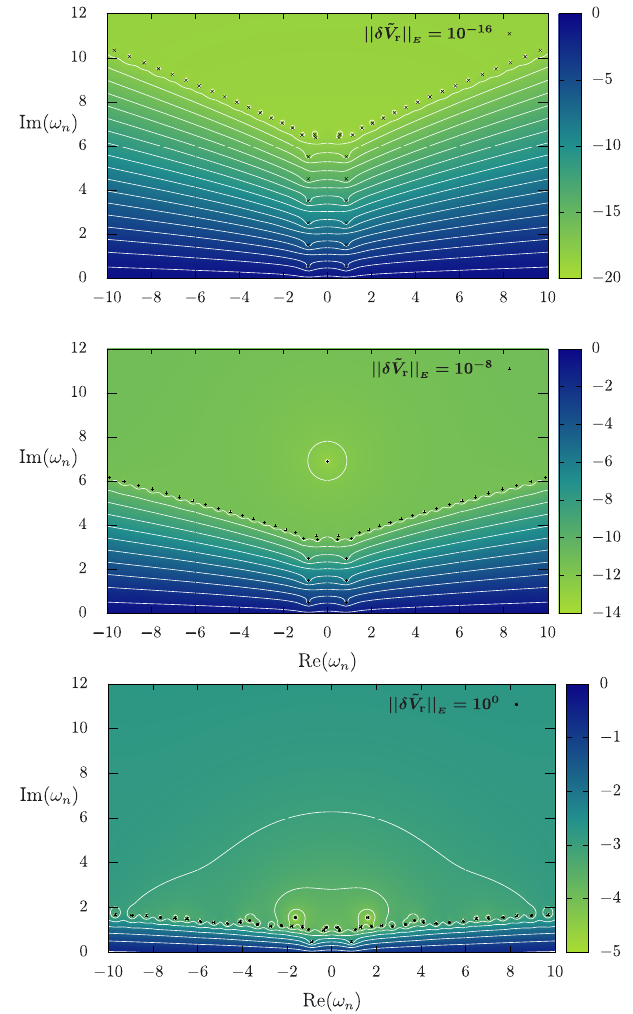
FIG. 11. Pseudospectra of the Pöschl-Teller potential under ˜ V random perturbations δ of increasing norm, demonstrating the r regularizing effect of random perturbations. Pseudospectra sets σ ϵ bounded by the contour line reached by perturbed QNMs become flat, a signature of improved analytic behavior of the resolvent, as illustrated in Fig. 6. Pseudospectra sets not attained by the ω Þ perturbation remain unchanged. Regularization of R L þ δ L ð ˜ V increases as k δ r k E